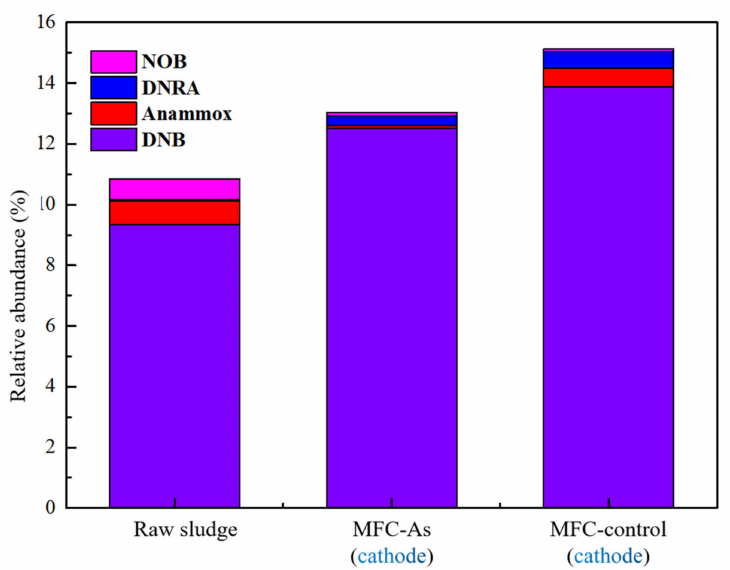
Figure 7. Relative abundance of functional genera in microbial samples of the cathode chambers.